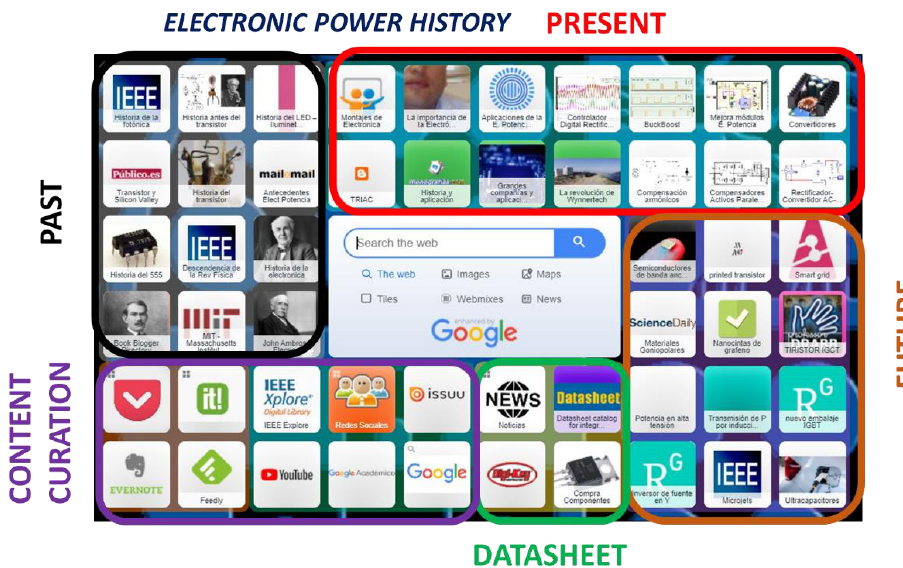
Figure 4. Example of a Symbaloo webmix as search step result.